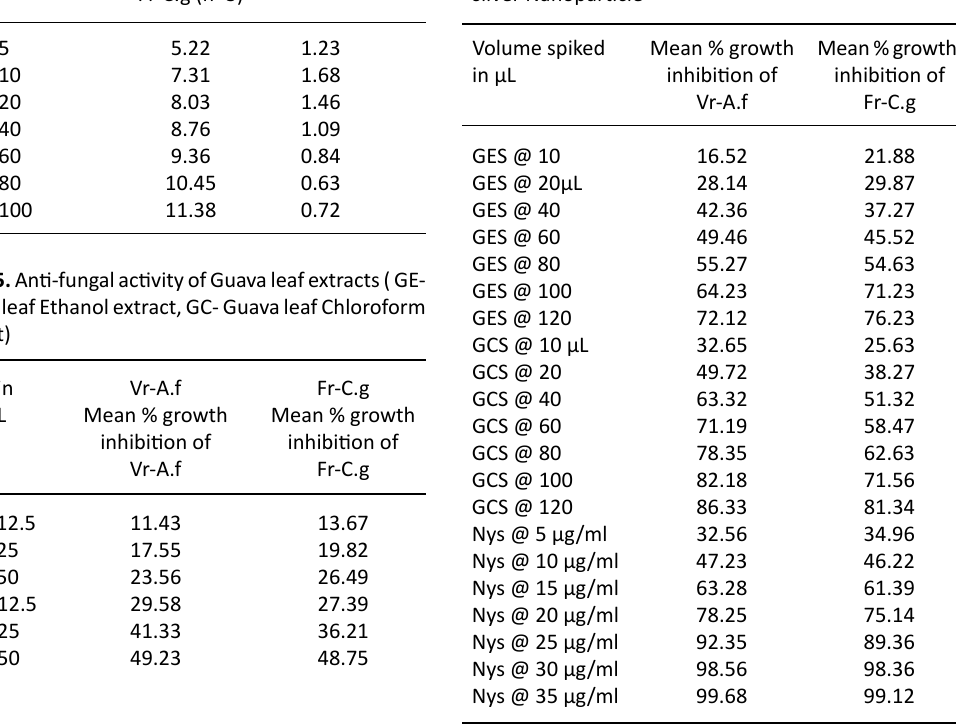
Table 6. Antifungal activity of Silver nanoparticles synthesised from guava leaf ethanol and Chloroform extracts. (GES- Guava Leaf Ethanol extract silver Nanoparticles, GCS- Guava Leaf Chloroform